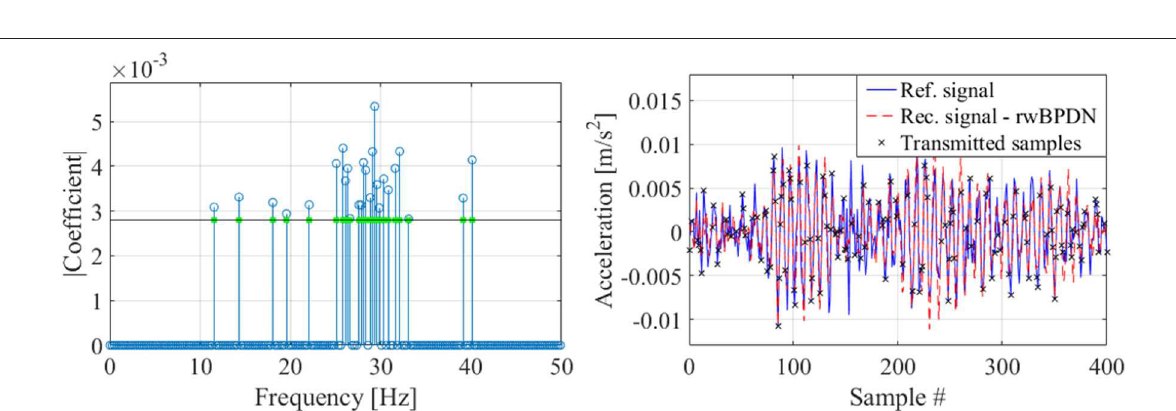
FIGURE 10 | Spectral domain projection (left) and time-domain recovery (right) of data-frame #4, channel #1 at CR used in the recovery